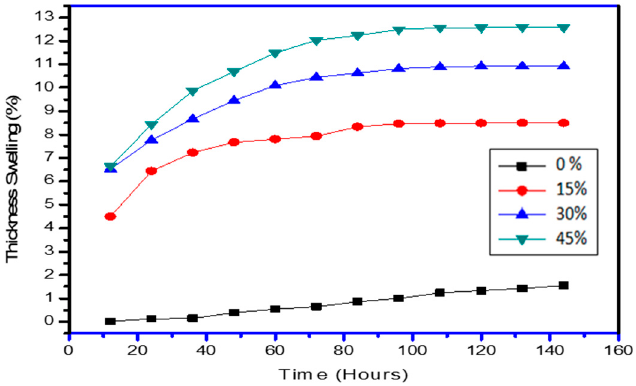
Figure 7. Thickness swelling properties of PCL-PCP composites.